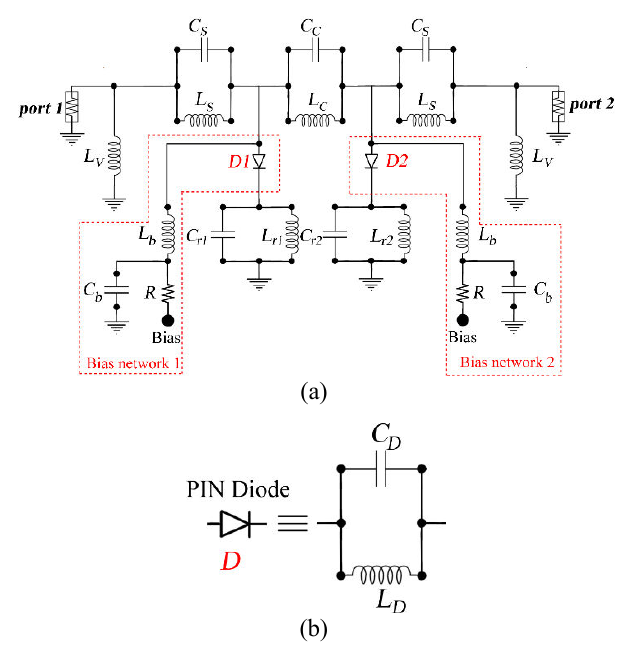
FIGURE 13. (a): the equivalent circuit of the reconfigurable SIW filter loaded with two different sizes C-HMCs using two PIN diodes, (b) the equivalent circuit of the PIN diode.